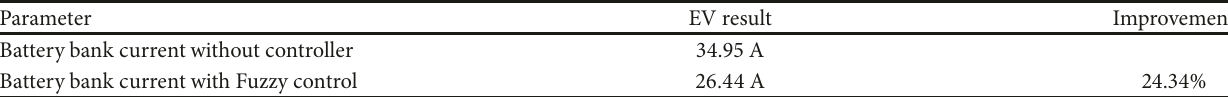
Table 7: Current average values over a cycle